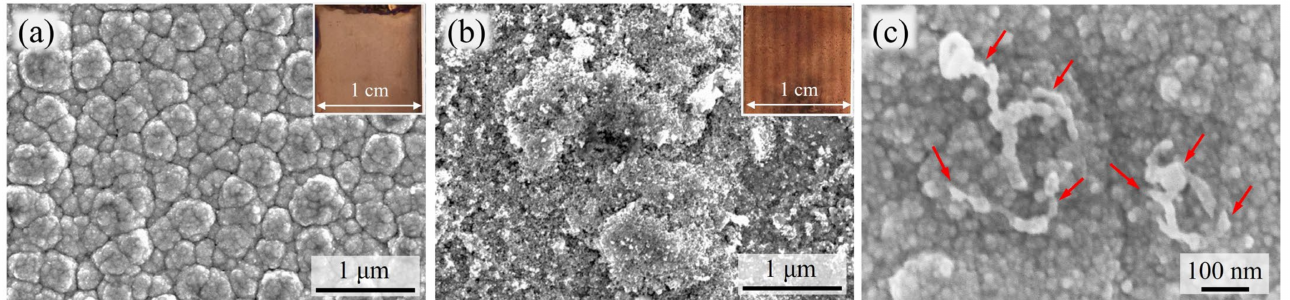
Figure 8. SEM images and photographs for pulse-deposited ( a ) Cu and ( b ) Cu/CNT composite platings; ( c ) shows high-magnification image of ( b ) and yellow colored arrows indicate codeposited CNTs. The pulse current density was − 30 mA/cm 2 .